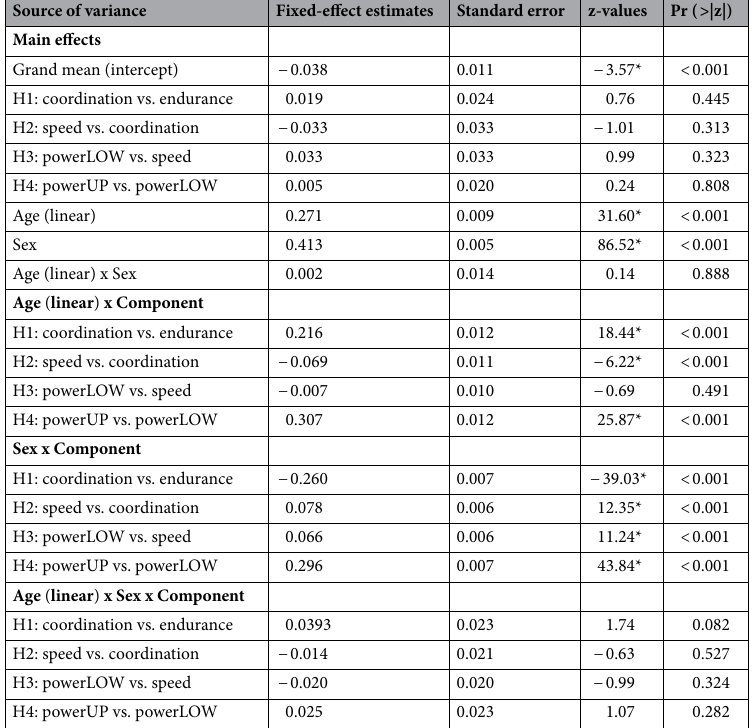
Table 1. Fixed-effect estimates of linear mixed model. H1 to H4 = hypothesis 1–4, endurance = cardiorespiratory endurance (i.e., 6 min run test), coordination = star run test, speed = 20-m linear sprint test, powerLOW = power of lower limbs (i.e., standing long jump test), powerUP = power of upper limbs (i.e., ball push test), * = z-value > 3.0, linear mixed model random factors: cohorts (9), schools (515), children (108,295), observations = 525,126 (missing = 3%). For estimates of variance components and correlation parameters see Table